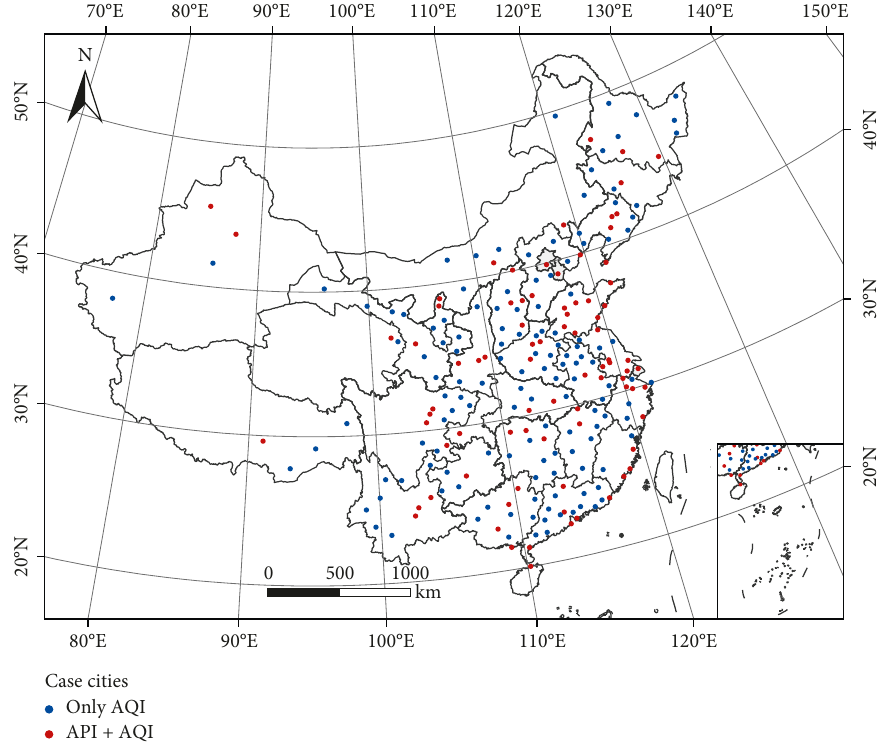
Figure 1: Locations of case